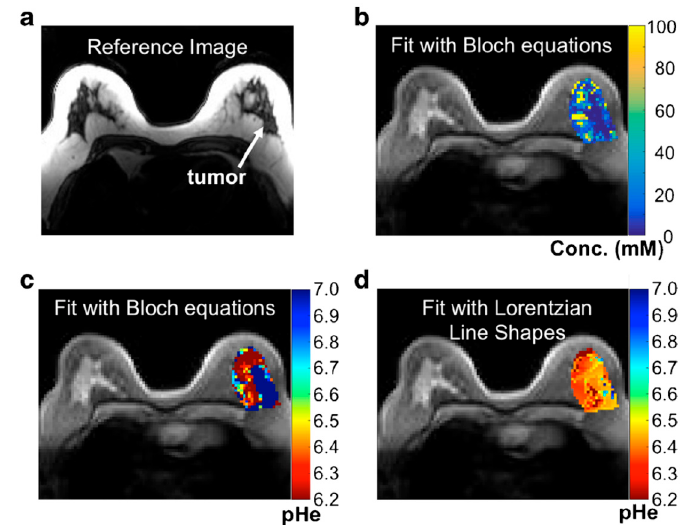
Figure 2. Parametric maps of the patient with high-grade invasive ductal carcinoma. ( a ) A representative image of the patient with high-grade invasive ductal carcinoma. ( b ) A parametric map of tumor concentration determined with Bloch fitting is overlaid on the anatomical image. ( c ) A parametric map of tumor pH e determined with Bloch fitting is overlaid on the anatomical image. ( d ) A parametric map of tumor pH e determined with Lorentzian fitting is overlaid on the anatomical image. (Reprinted with permission from Ref [108]).